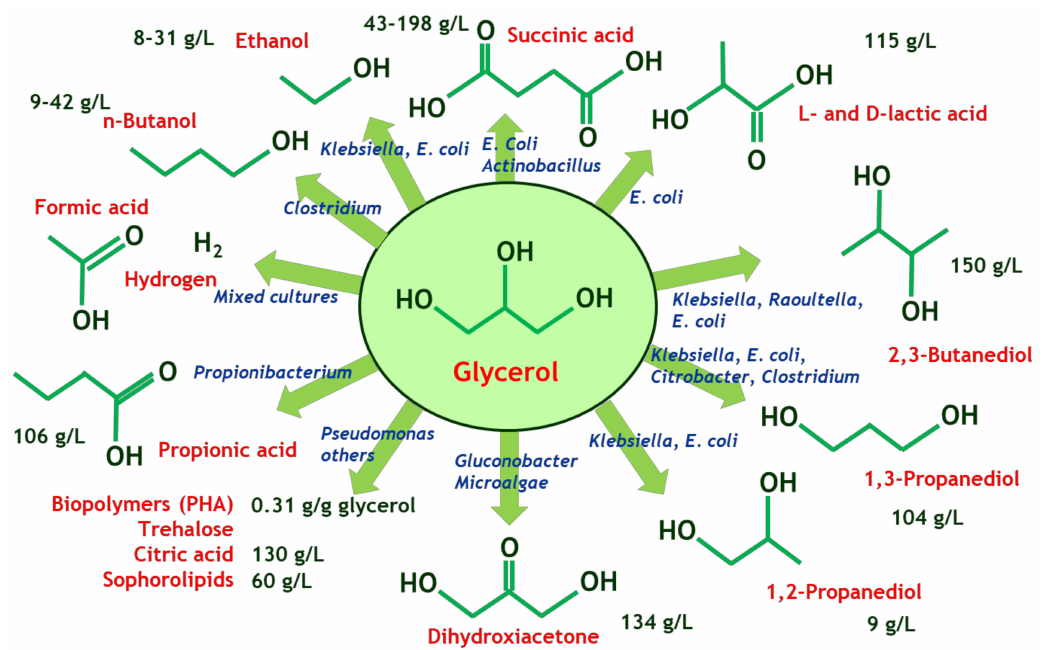
Figure 2. The glycerol biorefinery: microbial processes to several